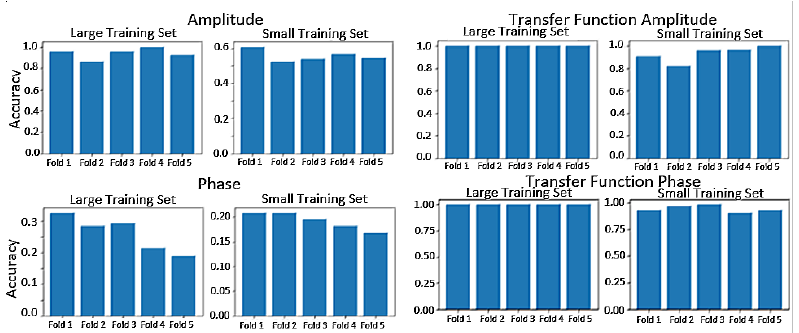
Figure 16. The accuracy for each fold in the K-fold validation is displayed for each configuration. It is evident that all models experience some decrease in accuracy on the small training set, but the transfer function models maintain excellent